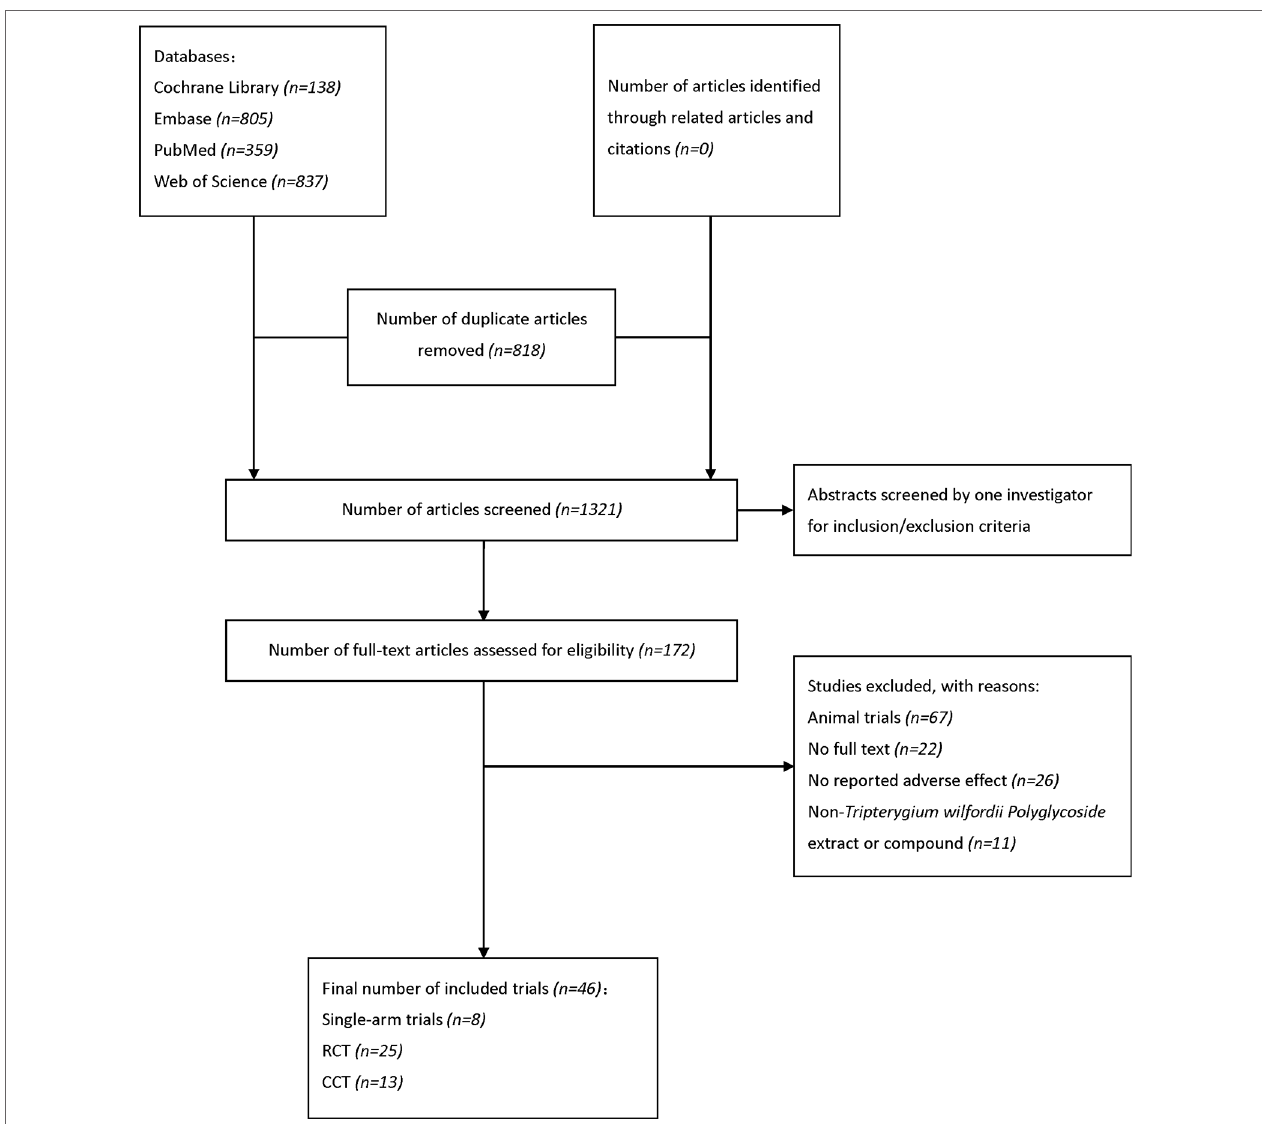
FIGURE 1 | Flow diagram of literature search and selection. EMBASE, Excerpta Medica Database; RCT, randomized controlled trial; CCT, controlled clinical